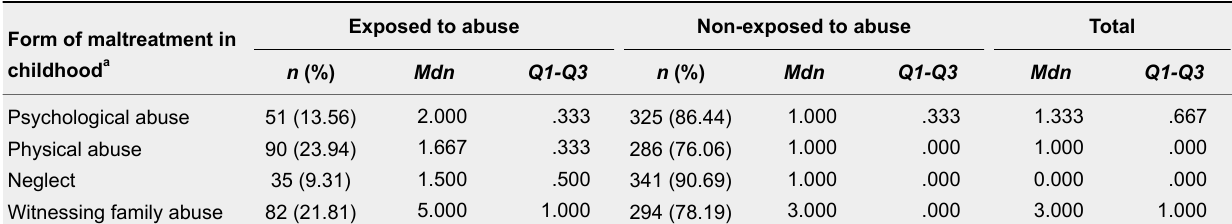
Descriptive Parameters of Prevalence of Different Form of Maltreatment in Childhood by Participants Exposed and Non Exposed to Abuse